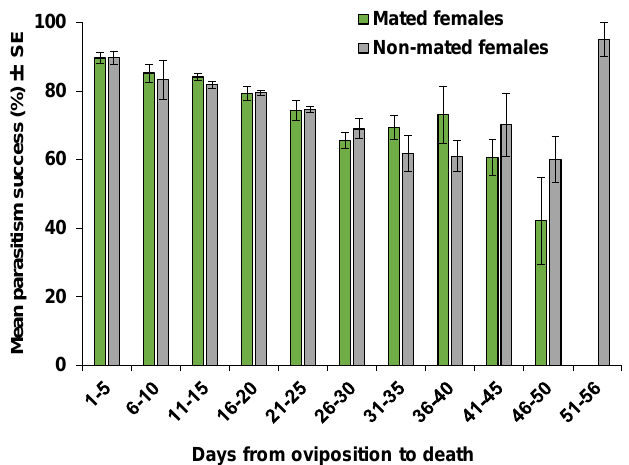
Figure 5. Parasitism success: mean ( ± SE) percentage of progeny emerged per eggs laid by all mated (n = 22) and non-mated (n = 19) females of Ooencyrtus lucidus on Bagrada hilaris eggs at five-day intervals from oviposition to death.